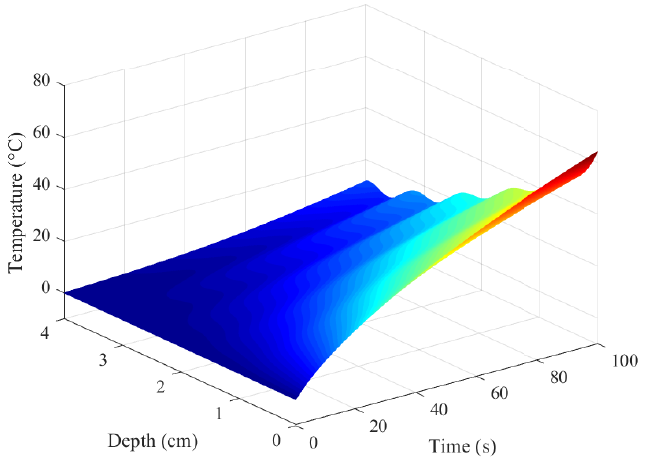
Figure 4. Global temperature distribution for the reduced-order model with microwave heating Debye